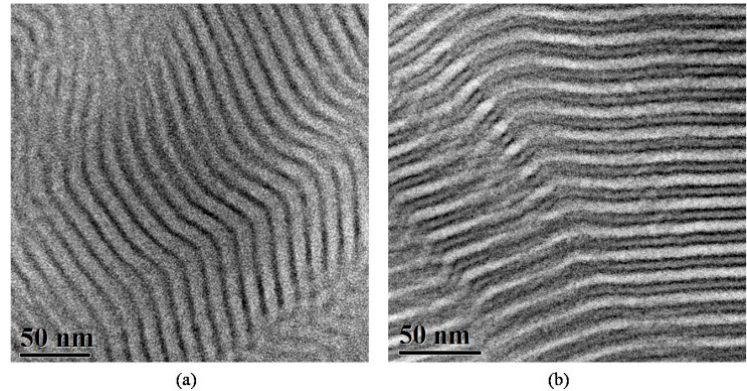
Figure 1. TEM images of the PS- b -PB 1,4 - b -PDMS terpolymer (sample 1). ( a ) Unstained sections where a two-phase alternating lamellae morphology is evident, with dark regions corresponding to PDMS and gray to the mixed PS / PB 1,4 segments, respectively. ( b ) Sections stained for 60 min with vapors of OsO 4 , leading to a very distinct three-phase four-layer alternating lamellae structure. Black corresponds to PB, white to PS and gray to PDMS domains.